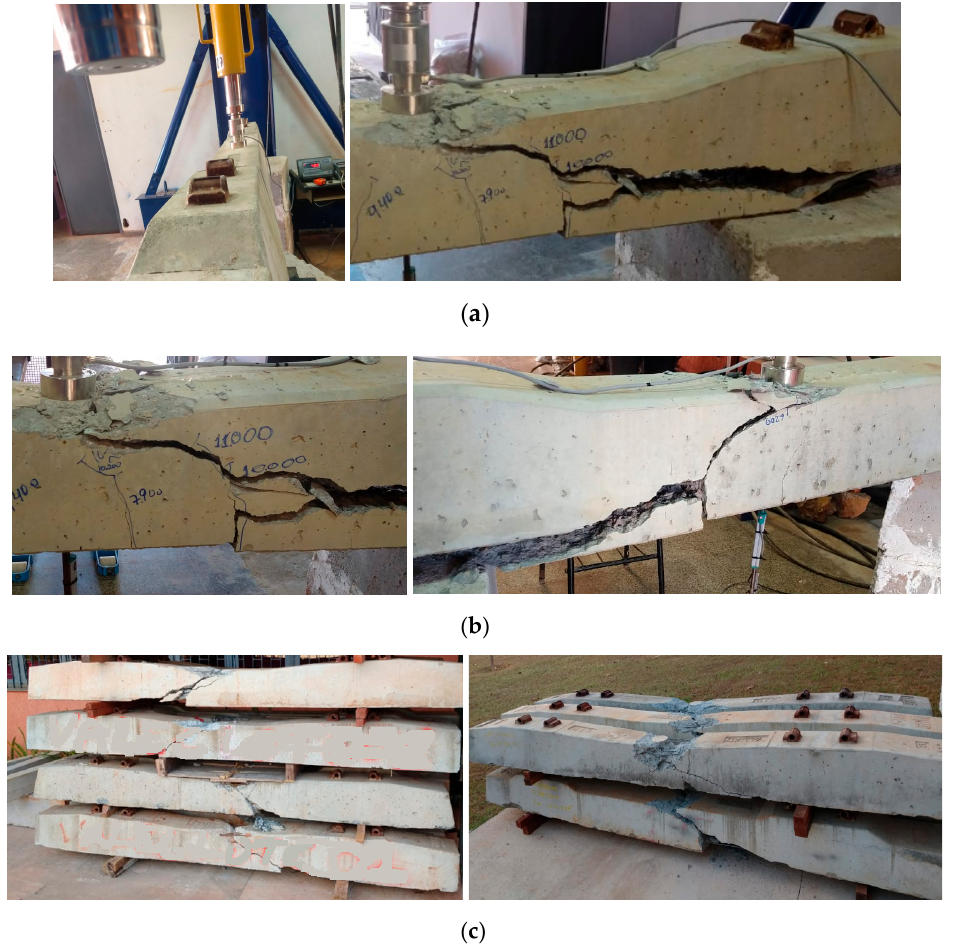
Figure 7. ( a ) Failure by simple bending; ( b ) failure in the positive moment test at the midspan; and ( c ) specimens tested in the INFRALAB Laboratory.